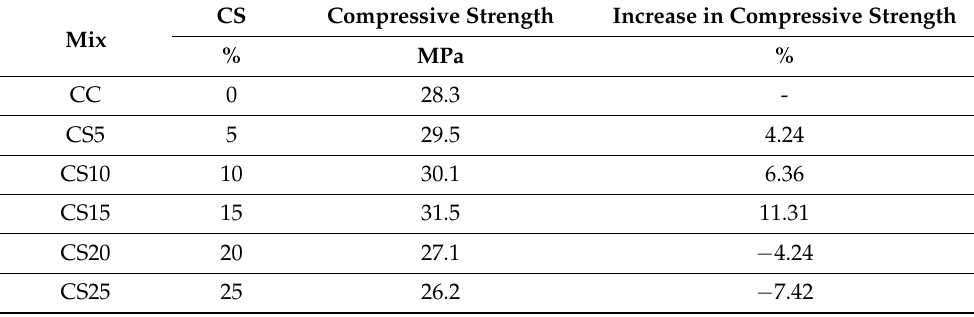
Table 3. Compressive strength of CS concrete.